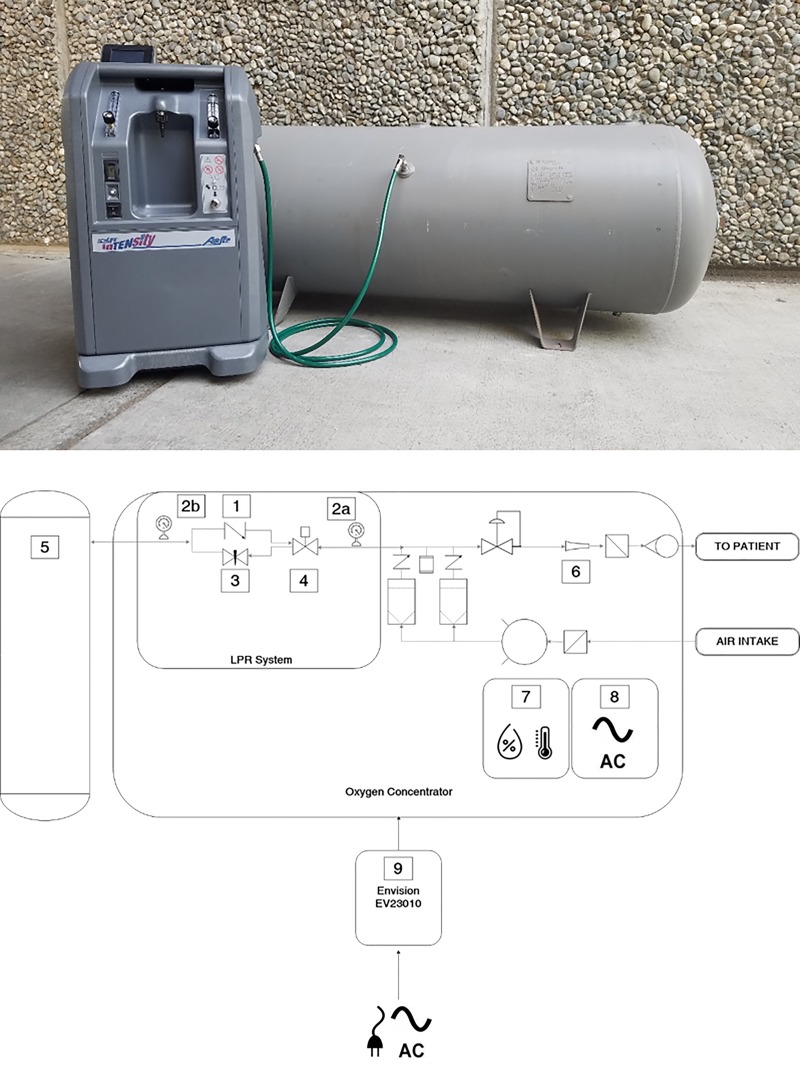
(A) Low-Pressure Reservoir system used in this study. (B) Low-Pressure Reservoir system is comprised of a reservoir and flow loop (1-check valve, 2-pressure sensor, 3-flow control orifice, 4-electrical solenoid, 5-reservoir, 6-flow meter, 7-temperature and humidity sensors, 8-power monitor, 9-surge protection) to store excess oxygen from the high pressure side of a concentrator. The sensors are added for monitoring purposes.